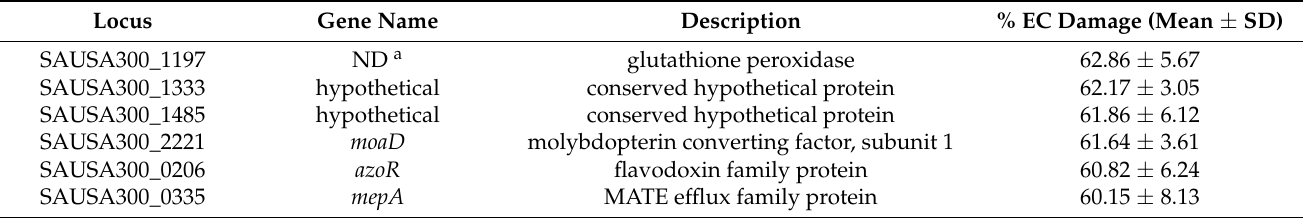
Table 2. Mutants significantly increase HMEC-1 damage vs. JE2 WT strain (EC damage rate ≥ 60%). Locus